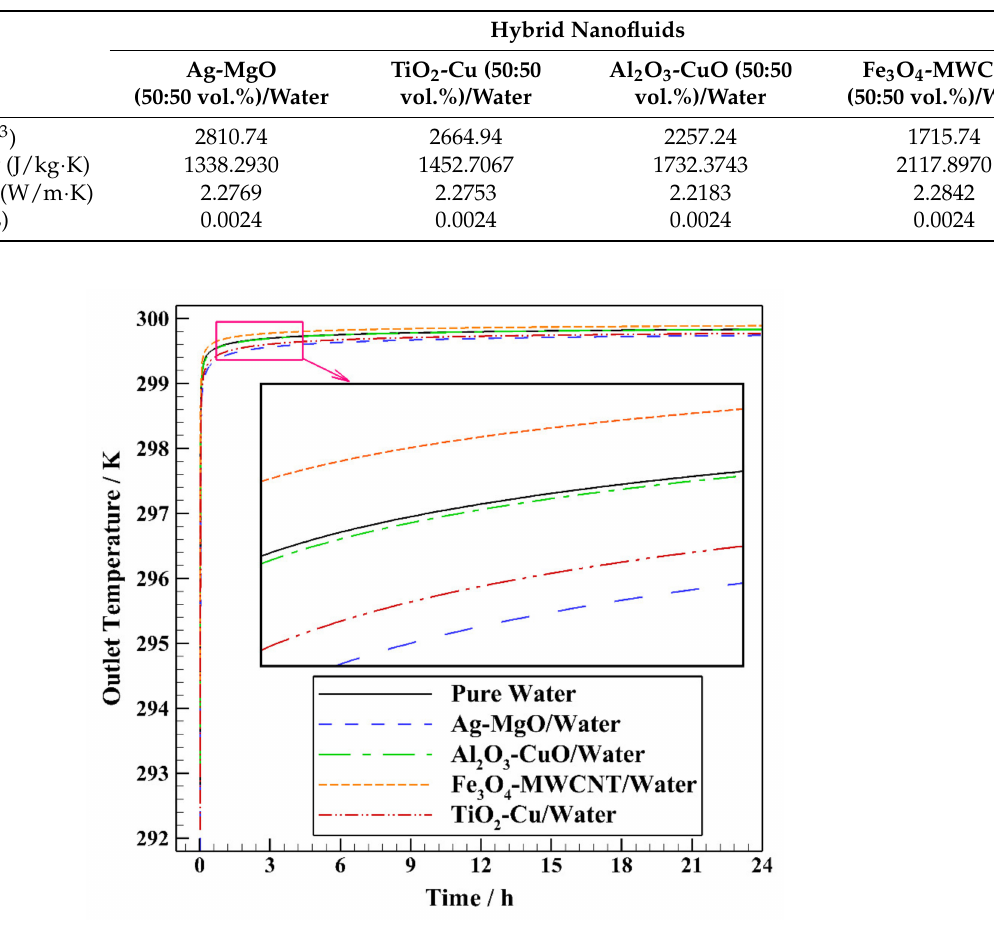
Figure 4. The variation of the outlet temperature with operating time using various hybrid nanofluids at φ = 0.15 and Re =